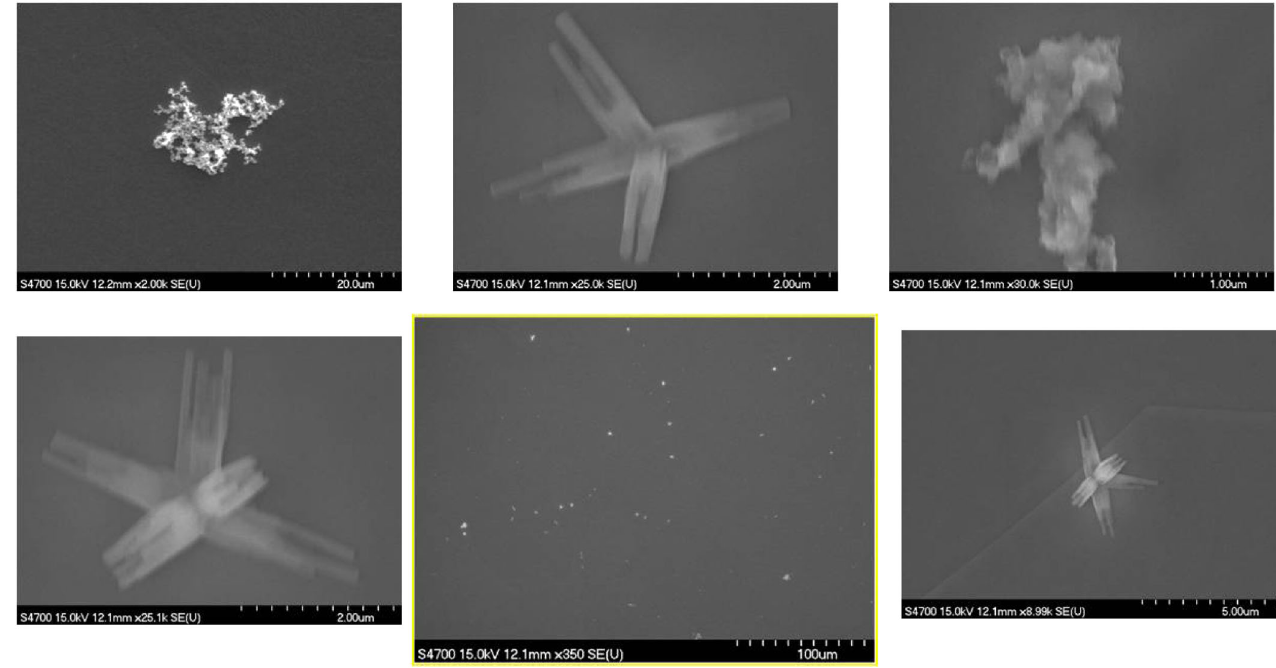
FIG. 12. Nb-O granules and crystallite-like particles were found on one area (the center figure in row 2) of sample 6.